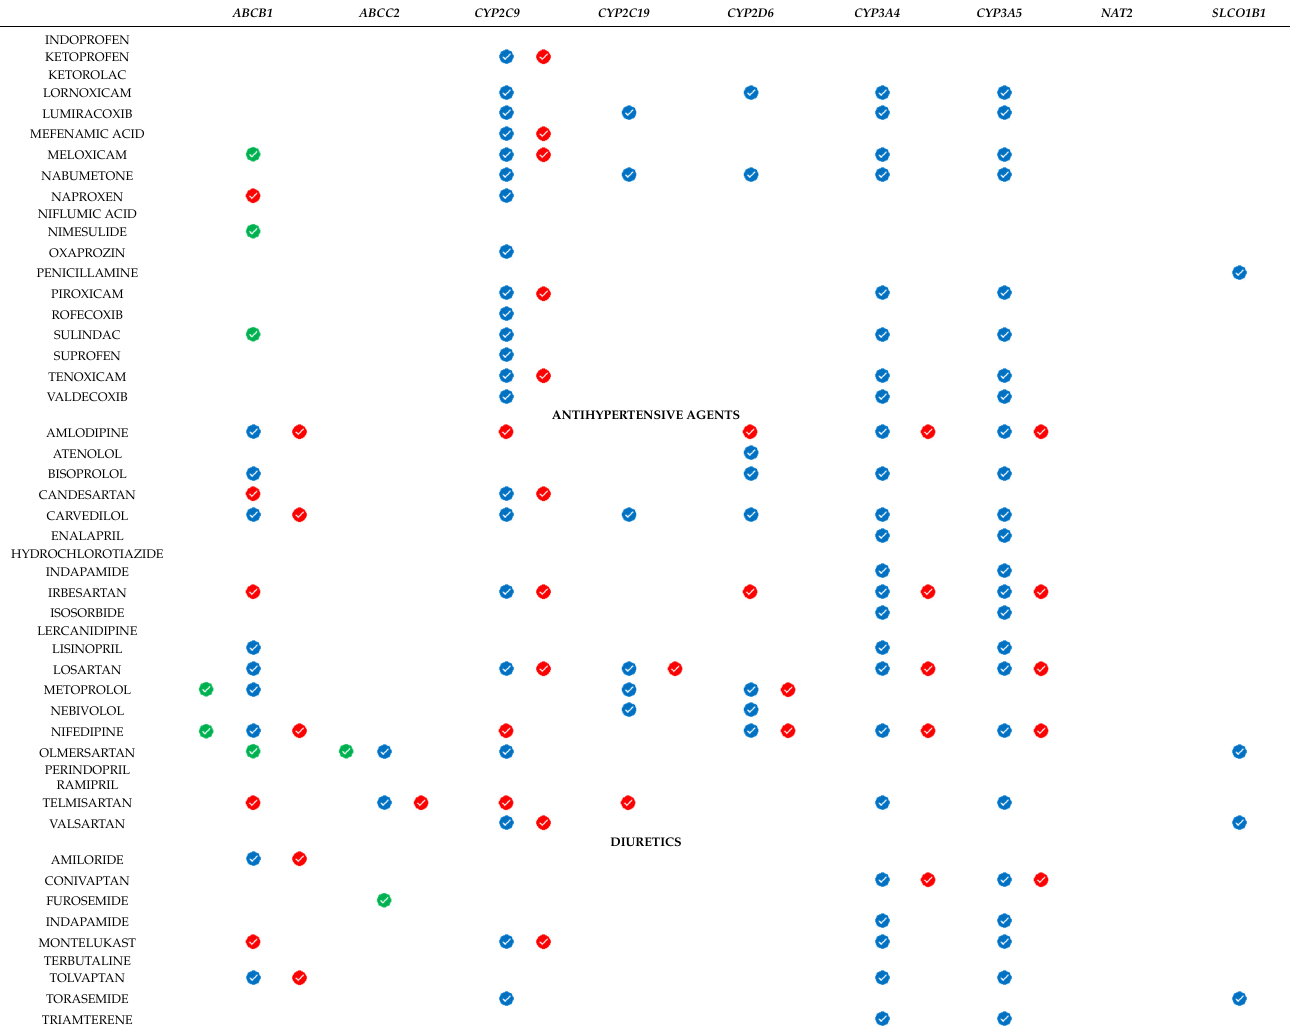
Table 4. COVID-19 pharmacogenetics.